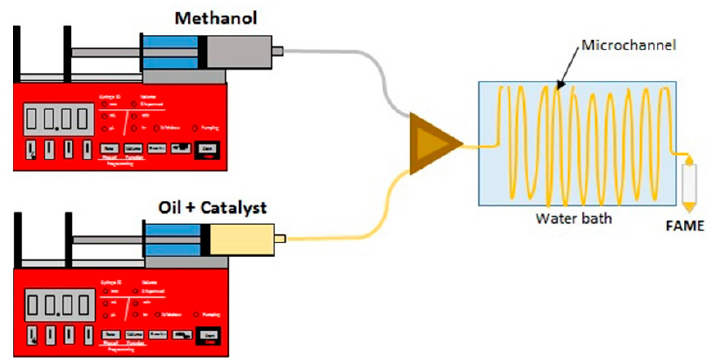
Figure 1. Transesterification microreactor setup.